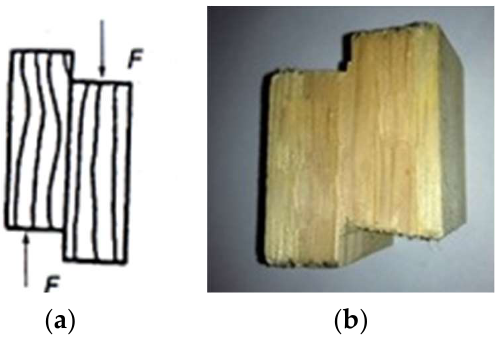
Figure 2. Block sample for testing the strength and resistance of glue lines: ( a ) schematic diagram; ( b ) photo.